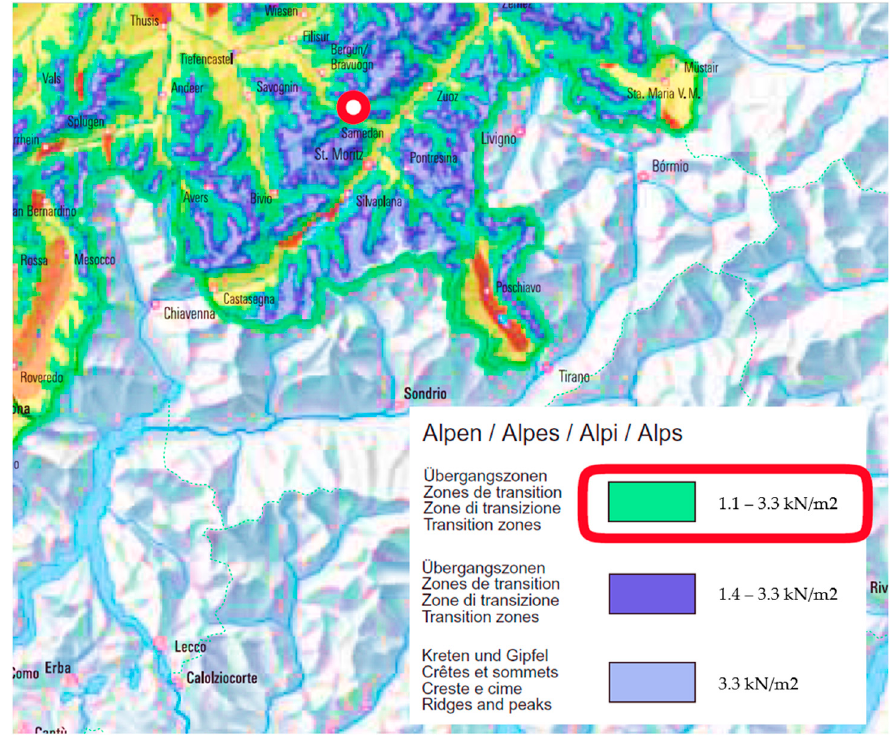
Figure 16. SIA 261/1, appendix E wind pressure map, Albula Pass highlighted [10].